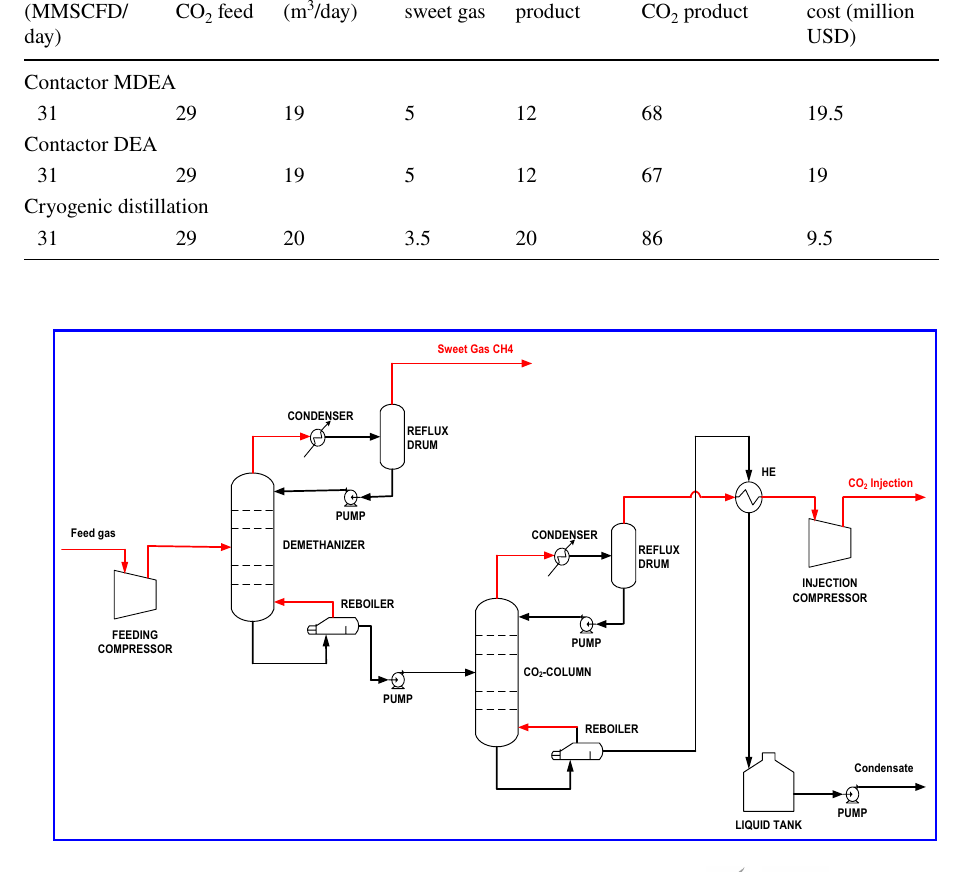
Table 4 Simulation results of CO 2 gas purification by various methods